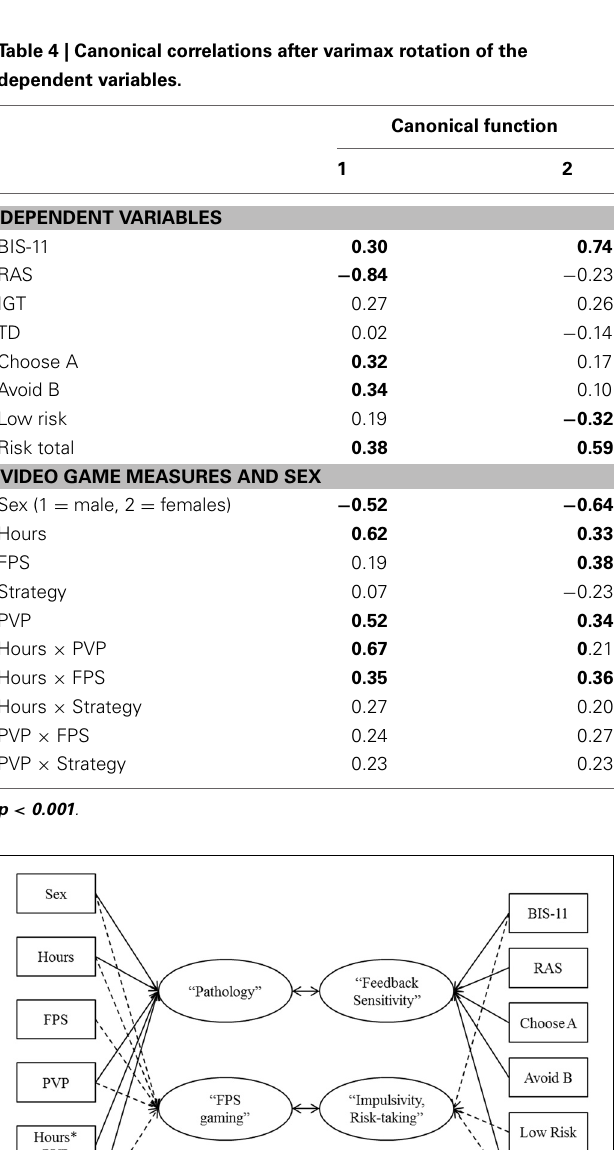
and losses on the risk task. The negative association with sex indicates that males engaged in more risky decision making than